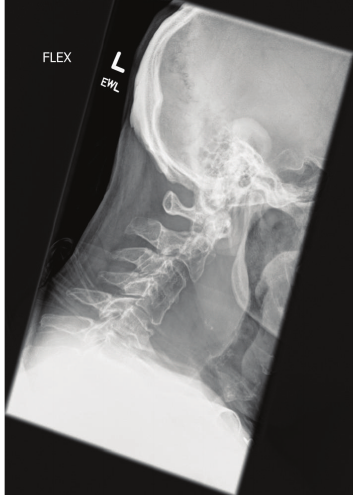
Figure 2: Lateral plain film taking in flexion demonstrating significant prevertebral soft tissue swelling with anterior tracheal